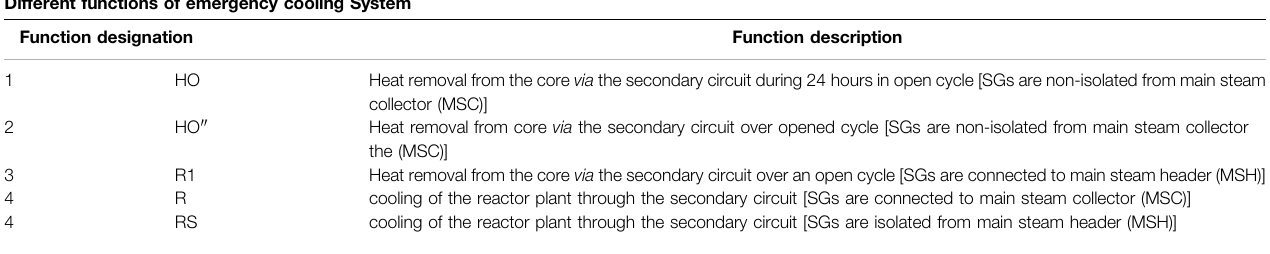
TABLE 5 | Description of Different Functions of the Emergency Cooling System (AEOI, 2014). Different functions of emergency cooling System Function